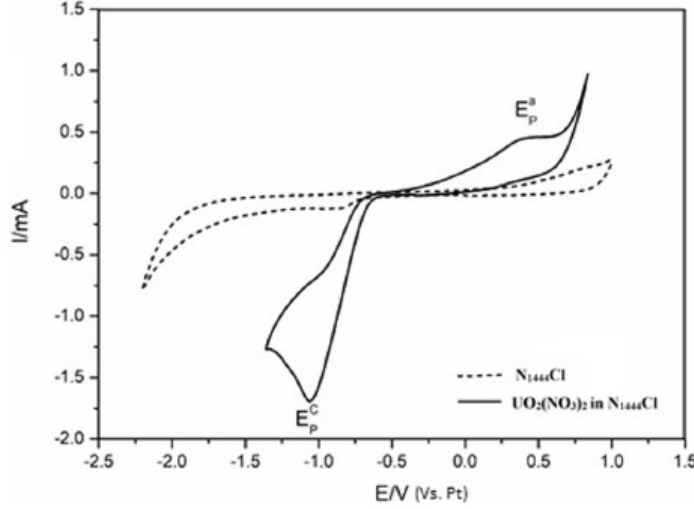
Figure 14. Cyclic voltammogram of [N 1444 ]Cl and UO 22 + in [N 1444 ]Cl recorded at glassy carbon electrode. [UO 22 + ] = 0.07 M, temperature = 383 K, scan rate = 100 mV s − 1 . Reproduced with permission from [62], copyright 2020, Elsevier.